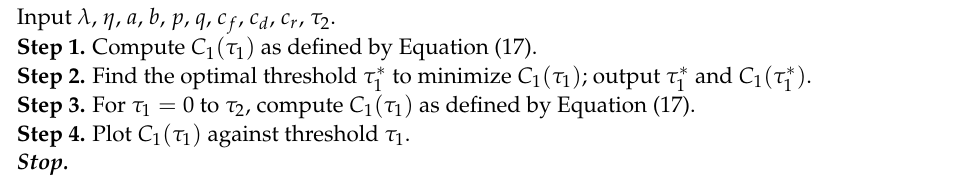
Algorithm 1 Long-Run Average Cost Rate under Policy N τ